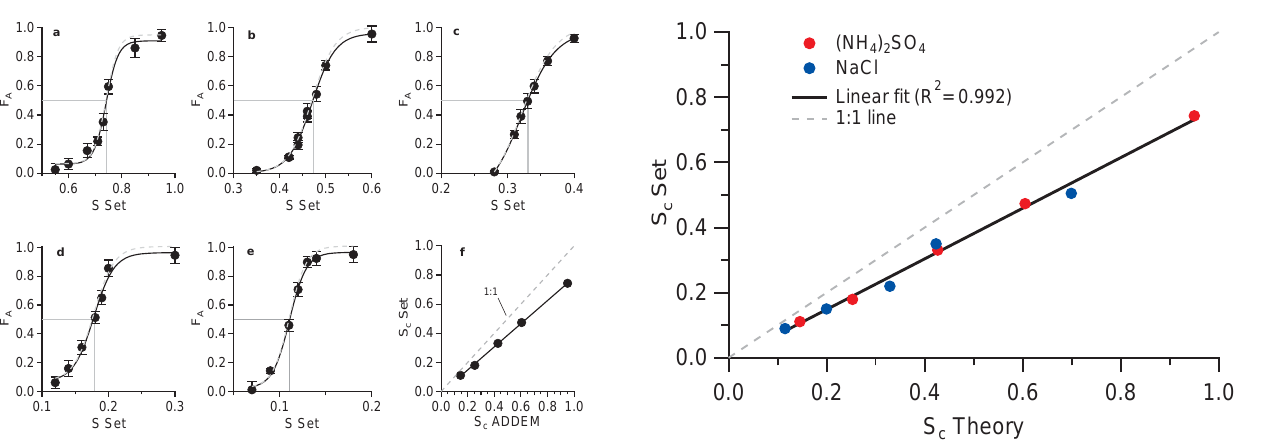
Fig. 5. CCN ammonium sulphate and sodium chloride calibrations from the MAP campaign. Set point vs. theoretical S c